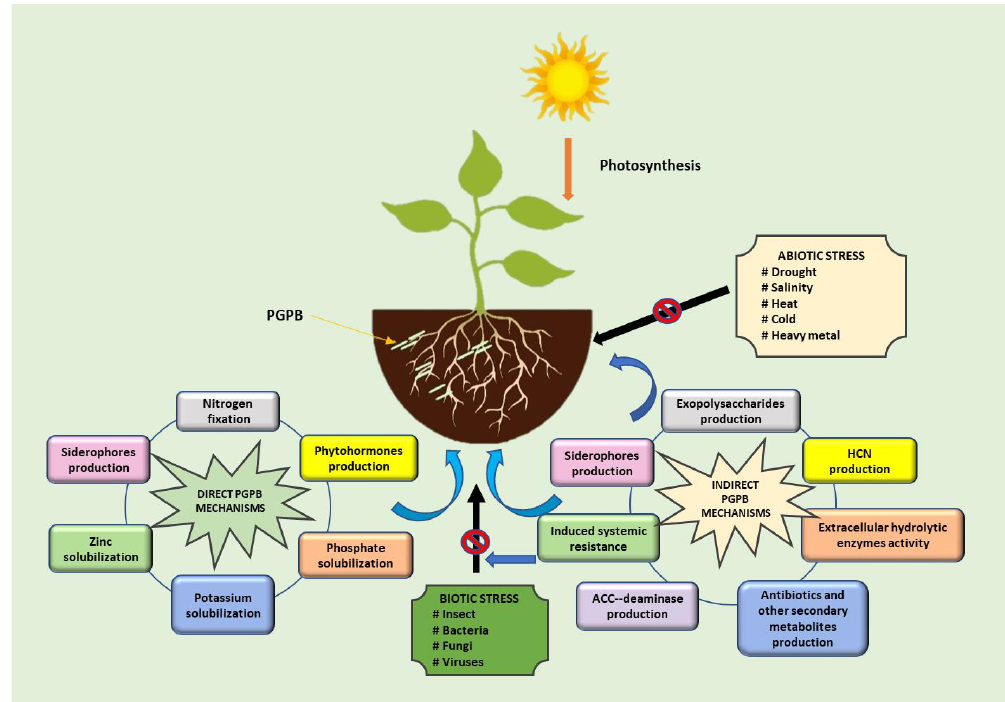
Figure 2. Direct and indirect mechanisms of PGPB to support the plant development.